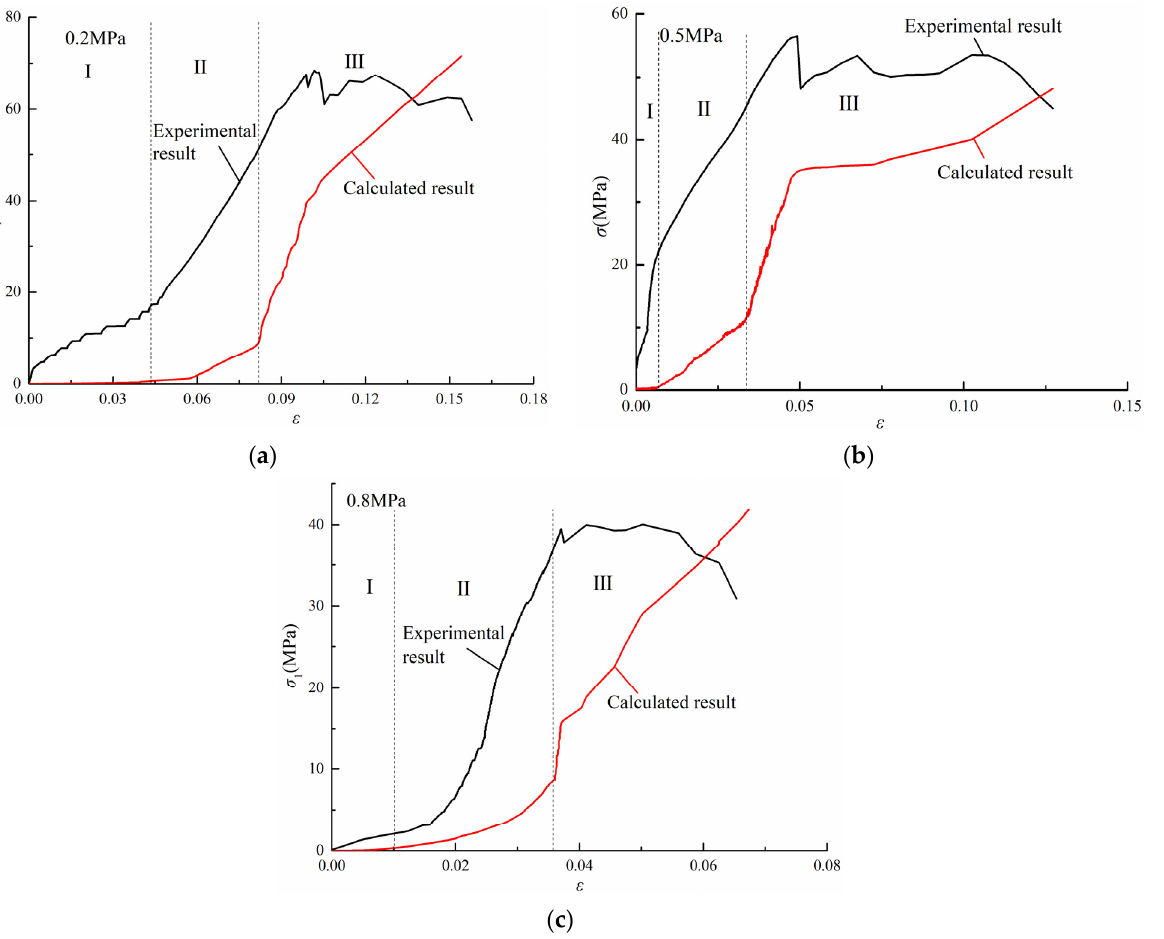
Figure 11. Calculated stress and measured stress for the conventional triaxial test. ( a ) Gas pressure of 0.2 MPa. ( b ) Gas pressure of 0.5 MPa. ( c ) Gas pressure of 0.8 MPa.